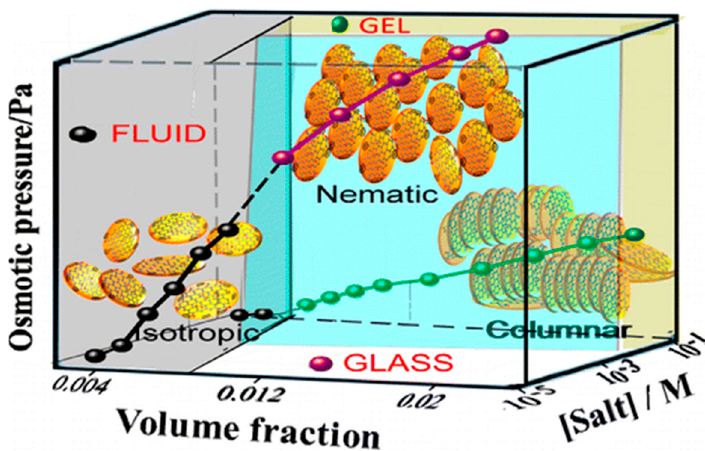
Figure 11. The phase diagram of graphene oxide dispersions as determined by Konkena and Vasudevan [46] displaying isotropic, nematic, columnar and glass phases. Reprinted with permission from ref. [46], Copyright (2014) American Chemical Society.